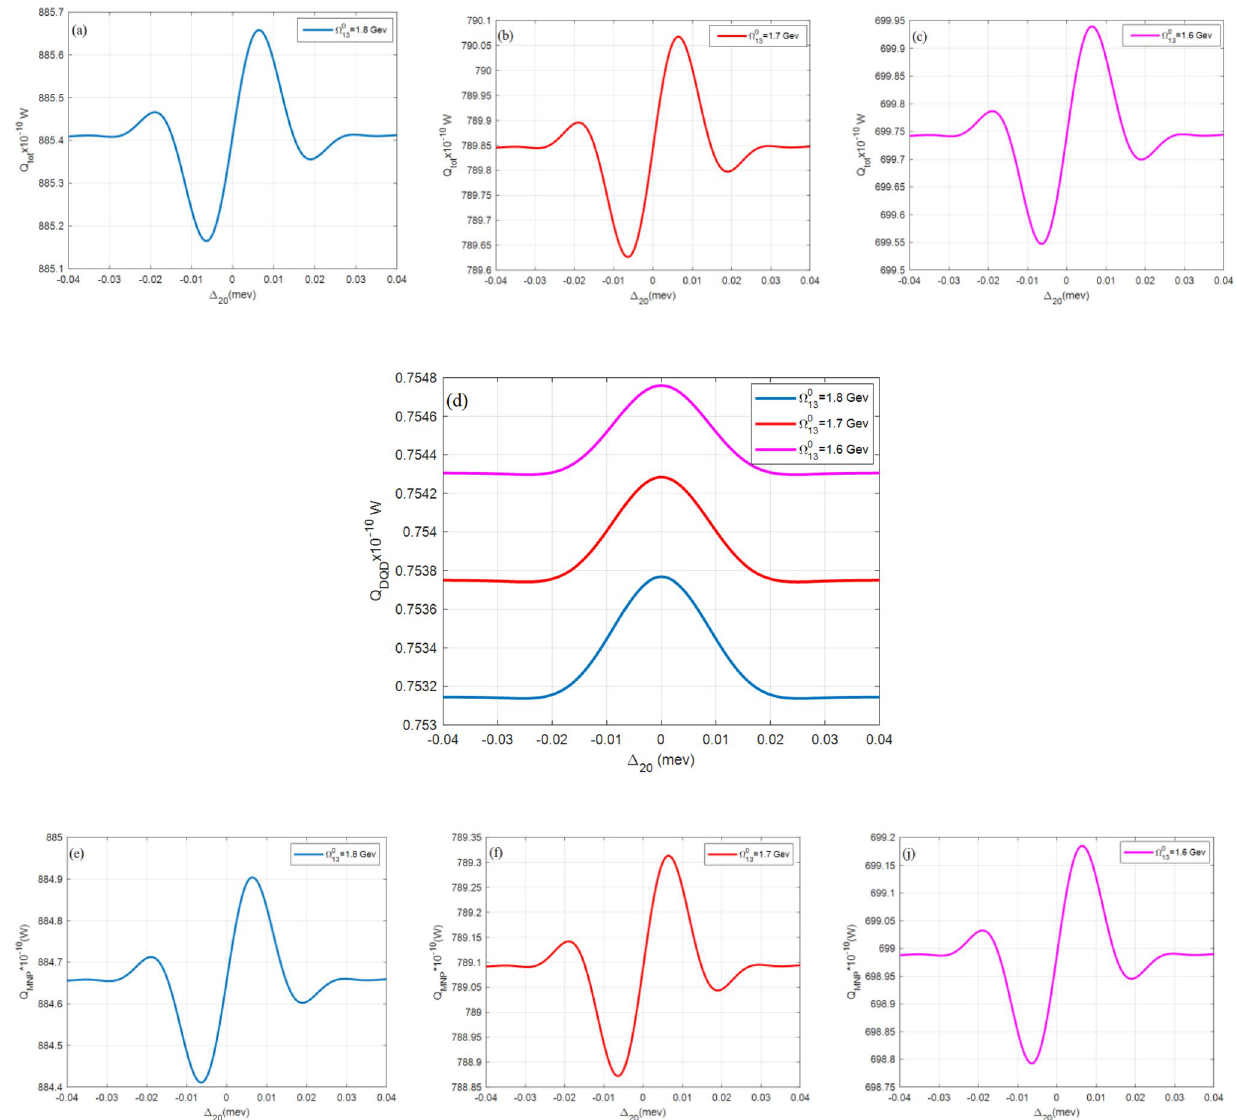
Figure 8. The absorption rates of the DQD-MNP hybrid system at R = 20nm under different pumpings. The total ( Q tot ) absorption rate at ( a ) (cid:31) 0 13 = 1.8GeV , ( b ) (cid:31) 0 13 = 1.7 GeV , and ( c ) (cid:31) 0 13 = 1.6GeV . The DQD ( Q DQD ) is in ( d ), and then MNP ( Q MNP ) in ( e ) (cid:31) 0 13 = 1.8GeV , and ( f ) (cid:31) 0 13 = 1.7 GeV , and ( j ) (cid:31) 0 13 = 1.6GeV . All these figures are with (cid:31) 0 02 = 0.09meV , T 01 = 30 γ 0 , T 32 = 8 γ 0